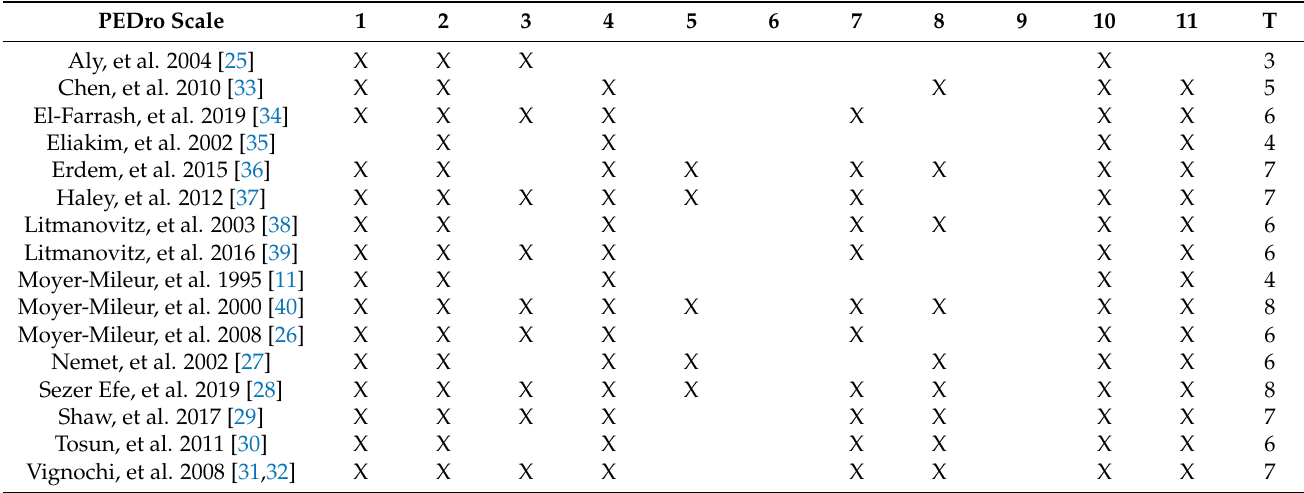
Table 3. Methodological quality assessed with PEDro scale.